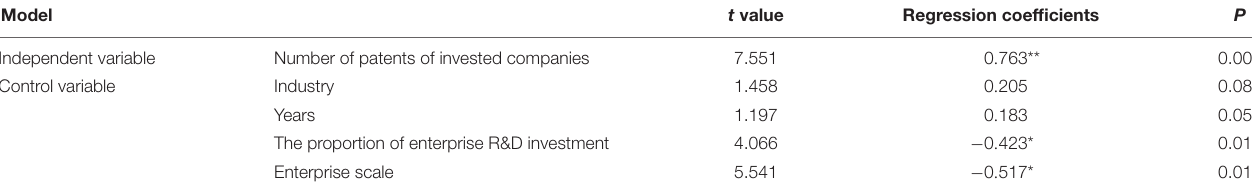
TABLE 5 | Regression analysis of enterprise Tobin’s Q ratio and enterprise innovation